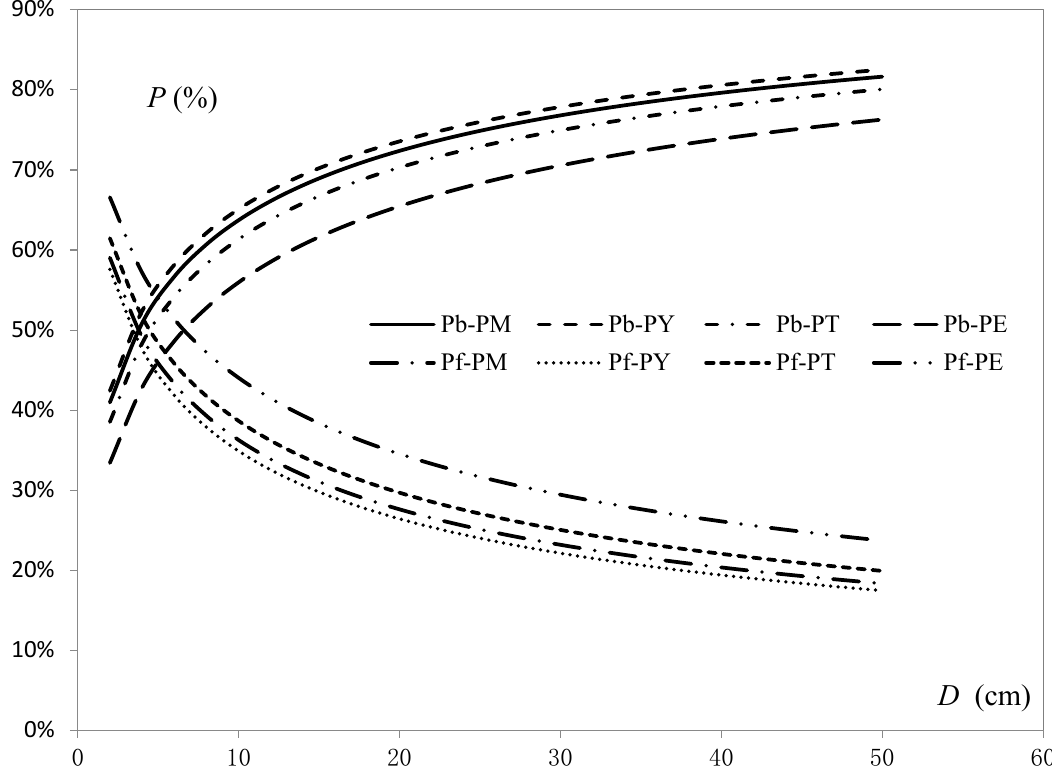
Figure 3. Comparison of proportions of branch and foliage biomass from compatible one-variable equations for the four pine species. (Pb—proportion of branch biomass, Pf—proportion of foliage biomass; PM— P. massoniana , PY— P. yunnanensis , PT— P. tabulaeformis , PE— P . elliottii